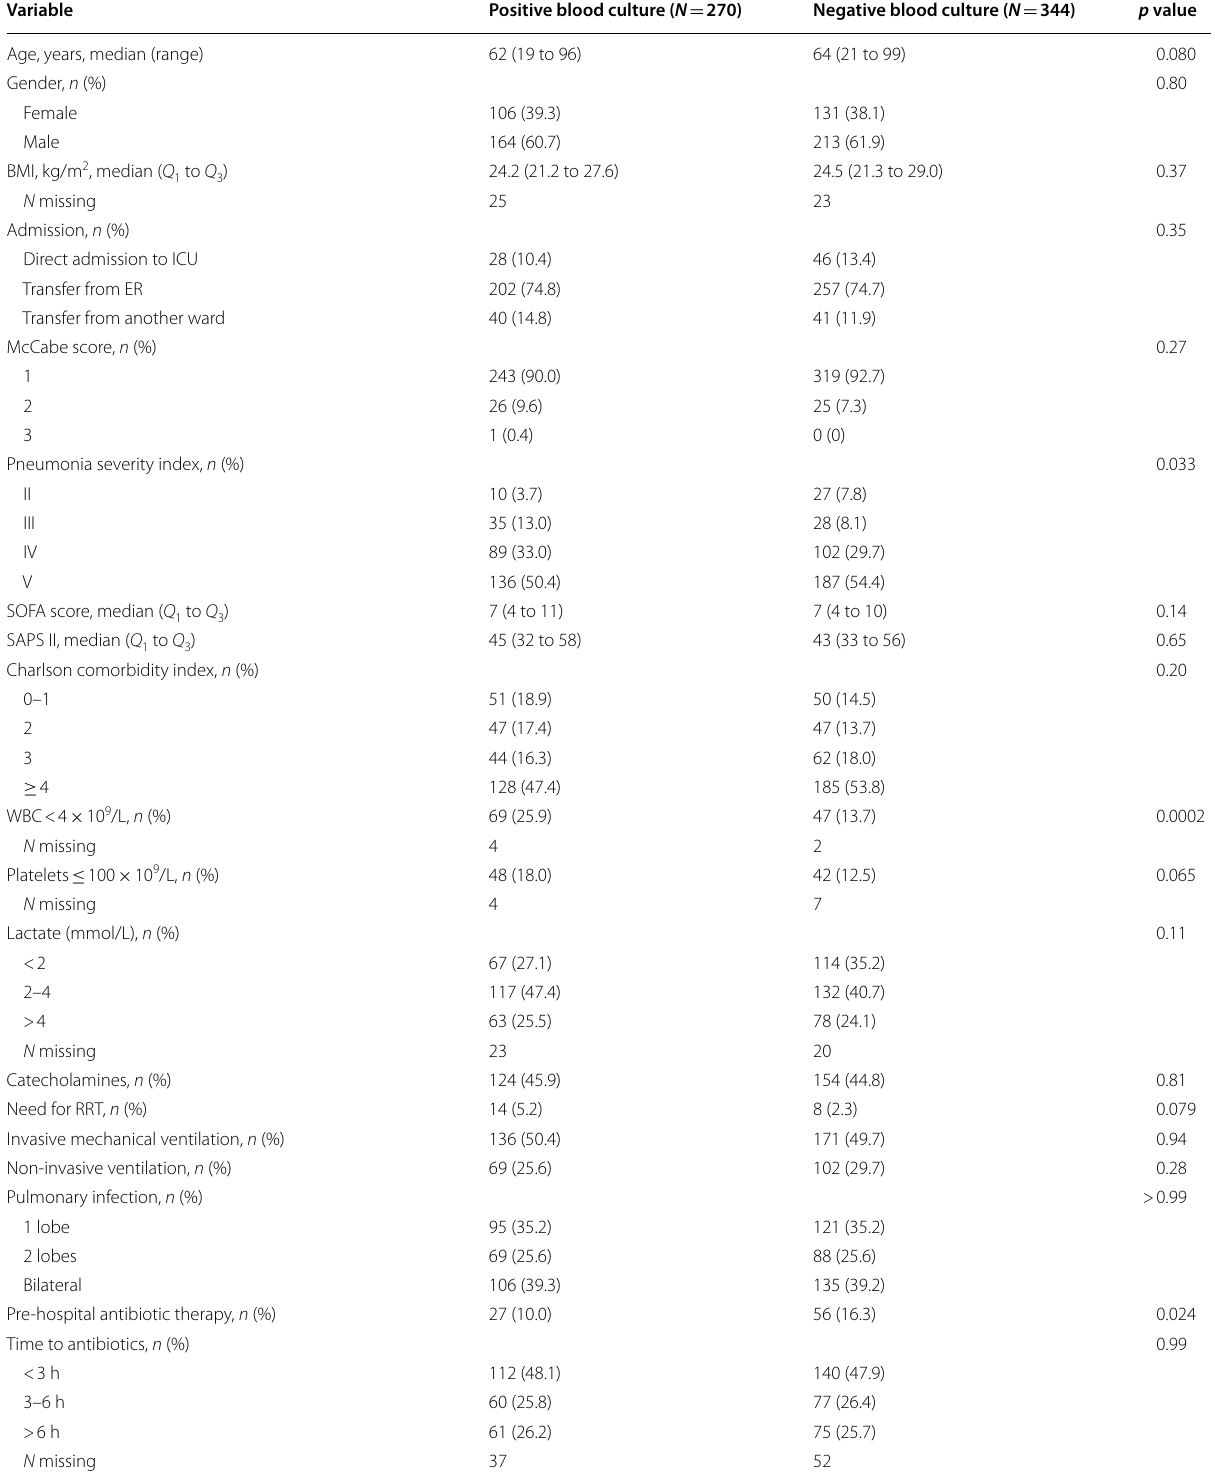
Table 1 Baseline characteristics of the 614 patients according to initial blood culture results